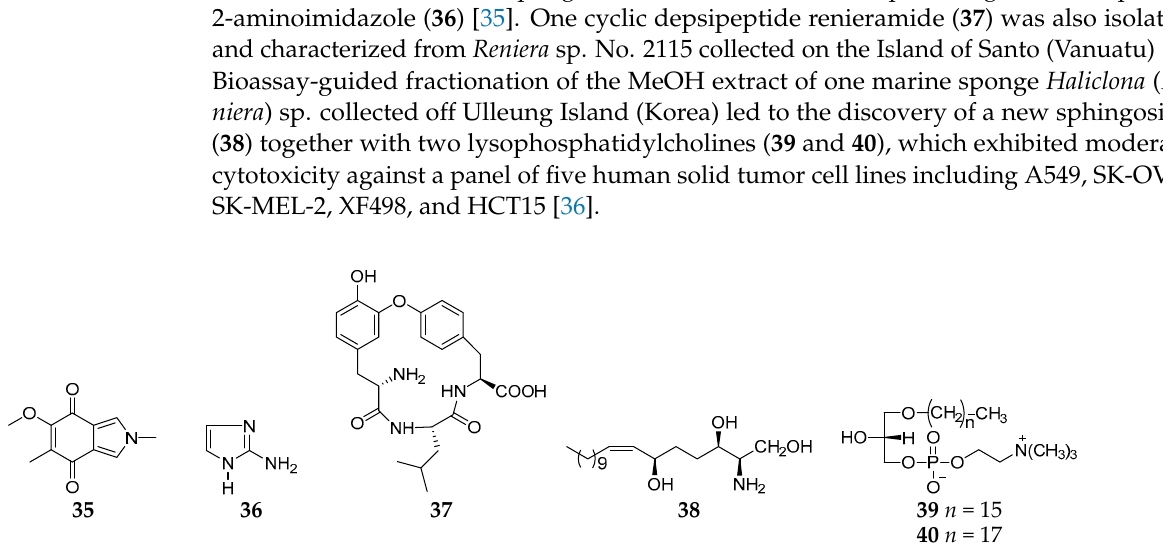
Figure 3. Macrocyclic diamines derivatives 28 – 34 from the subgenus Reniera .